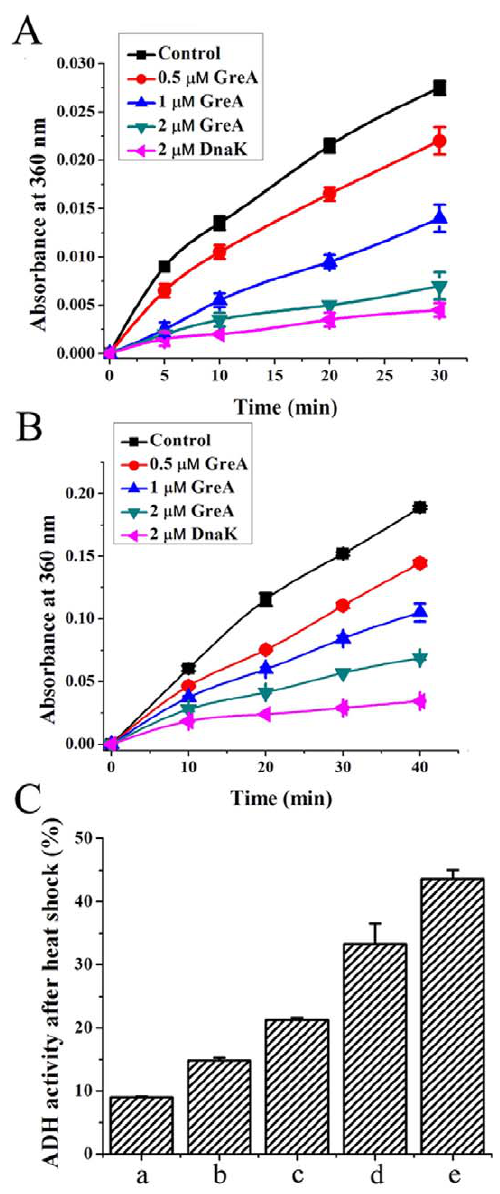
Figure 1. GreA inhibits heat-induced aggregation of substrate proteins. (A) ADH aggregation at 48 u C is suppressed in the presence of GreA. The control, 0.2 m M, 0.5 m M, 1 m M, 2 m M GreA or 2 m M DnaK was added to 1 m M ADH. Aggregation was started by incubation at 48 u C and detected by optical density at 360 nm. (B) GreA inhibits aldolase aggregation at 50 u C. 1 m M aldolase containing 0.5 m M, 1 m M, 2 m M GreA or 2 m M DnaK was incubated at 50 u C. Aldolase only was set as a control. The aggregation was detected by optical density at 360 nm. (C) GreA protects ADH enzymatic activity under heat shock conditions. 0.3 m M ADH with 0.3 m M (b), 0.6 m M (c), 1.2 m M GreA (d), 1 m M DnaK (e) or ADH only (a) was incubated at 50 u C. The enzymatic activity was measured after incubation for 80 min.